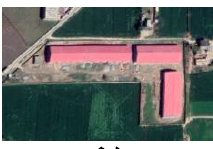
Figure 6: (a) Spectral signature of ground object at false positive target location, (b) HR image of the location.